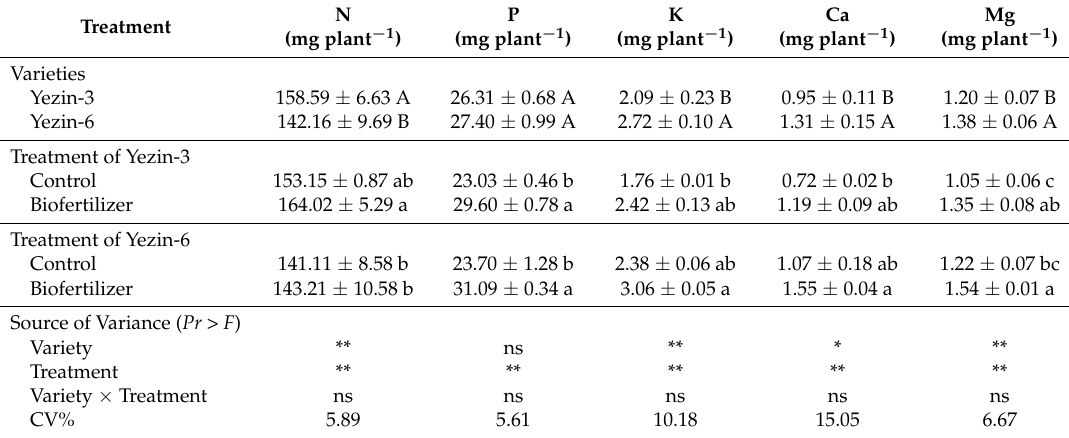
Table 7. Effect of biofertilizer on N, P, K, Ca and Mg uptakes of Yezin-3 and Yezin-6 soybean varieties at R3.5